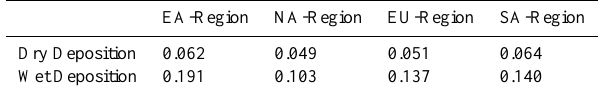
Table 3. The inter-annual variations in dry and wet aerosol depo- sitions with the standard deviations (tonskm − 2 ) averaged during 1995–2004 over four